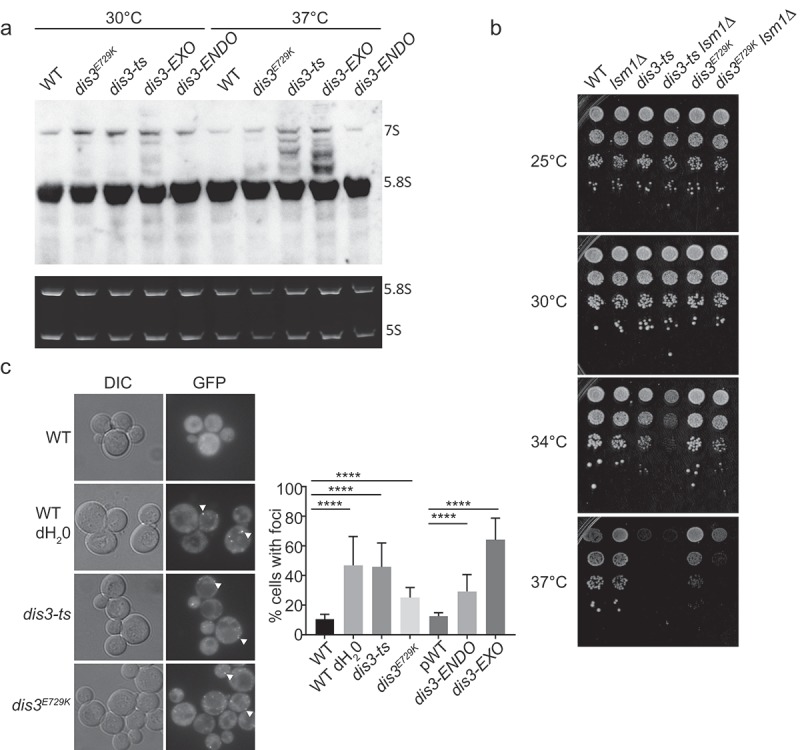
RNA processing phenotypes of DIS3 alleles. (a) Northern blot of 5.8S rRNA maturation products in early-log phase cultures. The top panel is a 15 second exposure after hybridization with a 5.8S rRNA-specific probe, and bottom panel is an ethidium bromide stained gel demonstrating RNA loading. (b) Spot dilution assays showing genetic interaction of dis3-ts and dis3E729K with loss of the P-body component Lsm1. (c) Representative images (left) and quantification (right) of Lsm1-GFP labelled P-body formation in DIS3 mutant alleles. Arrows indicate representative foci. **** indicates a p < 0.0001 via a Fisher exact test with Holm-Bonferroni correction.